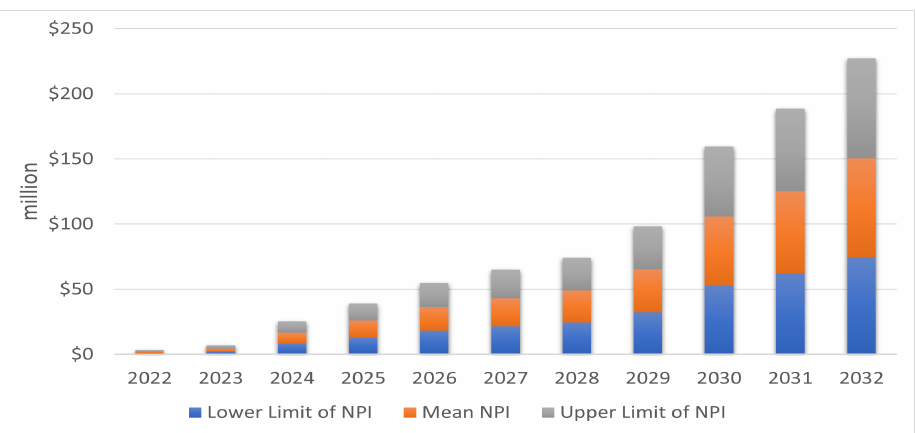
Figure 9. Estimated yearly net positive gain considering nine benefit factors and CAPEX-OPEX